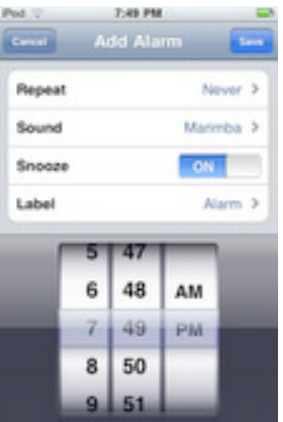
Figure 3 . The alarm screen.